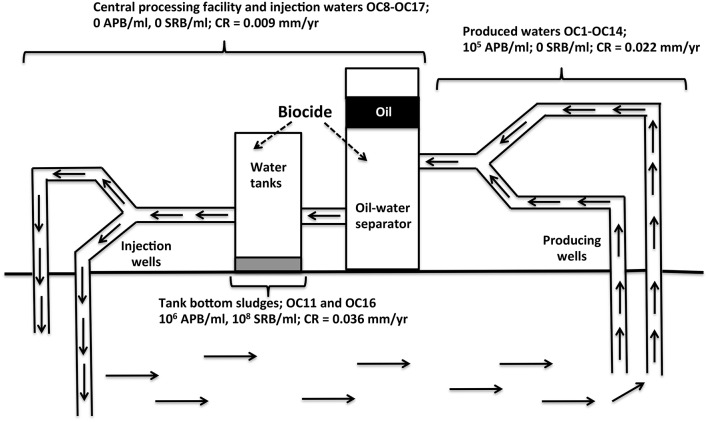
Schematic of Oceania oil field from which samples OC1 to OC18 were obtained (Table 1). Samples of produced waters contained some oil, as these were collected upstream from the oil-water separator. Weekly biocide addition to water tanks of the central processing facility eliminated planktonic APB, but tank bottom sludges retained high numbers of APB and SRB and had the highest general CR.